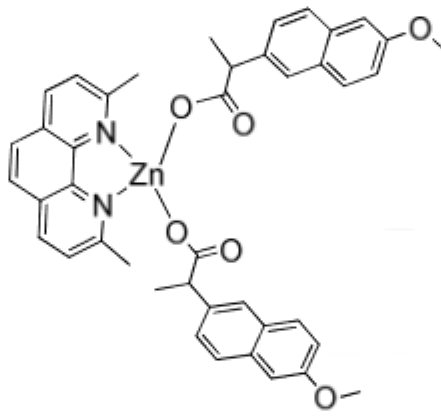
Figure 8. Zinc naproxen complex exhibiting strong antimicrobial properties against S. aureus [60].